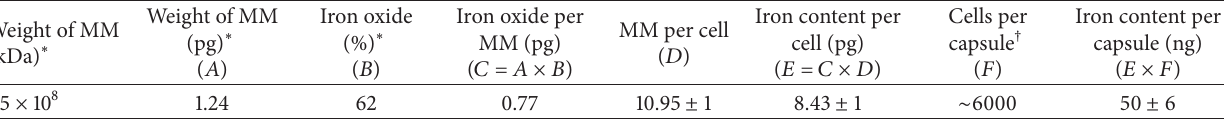
Table 1: Estimation of iron content of encapsulated MM-labelled cells. Weight of